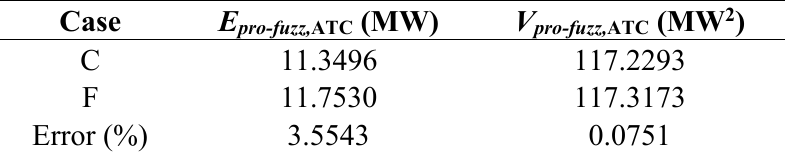
Table 4. The results of Case C and Case